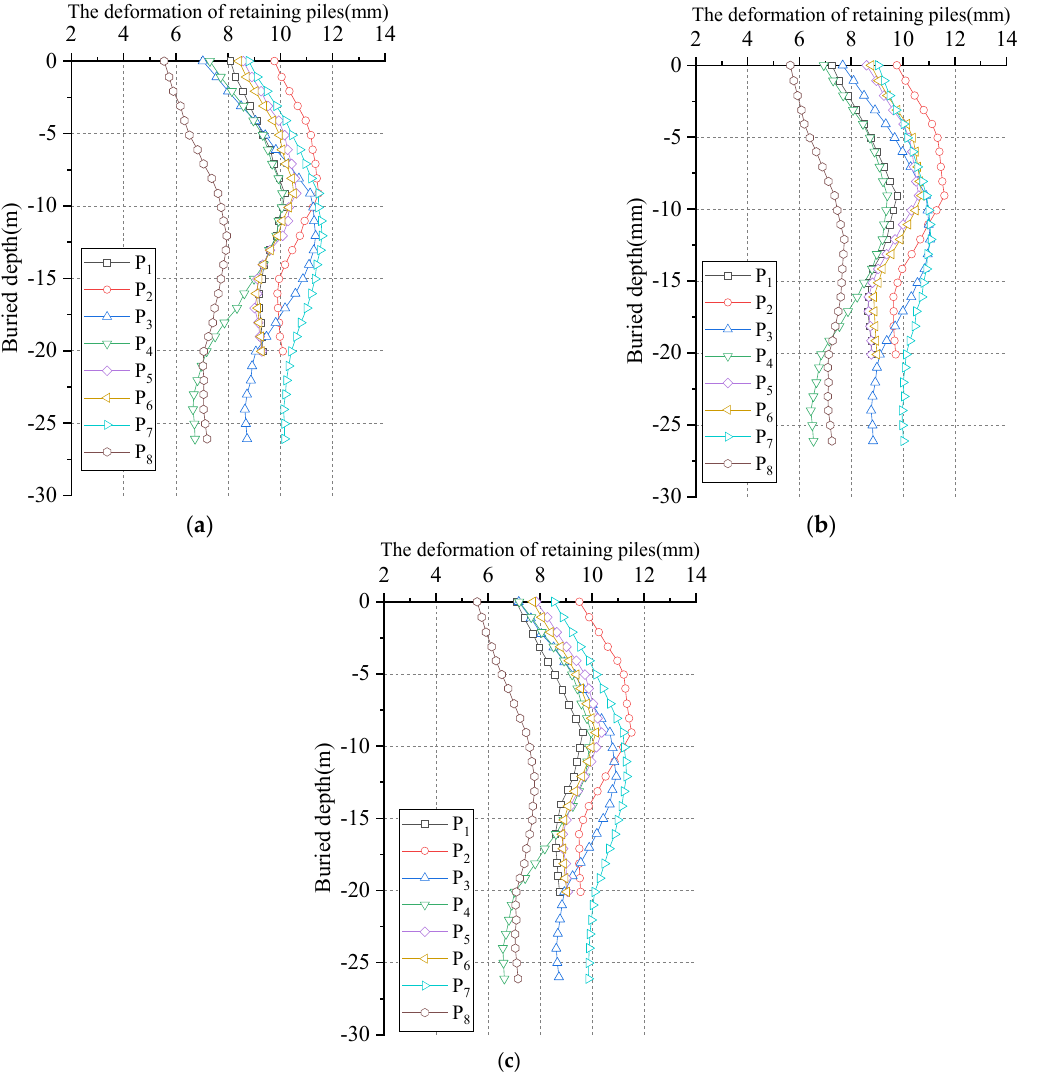
Figure 12. Deformation of the exterior retaining structure. ( a ) working Condition 1. ( b ) working Condition 2. ( c ) working Condition